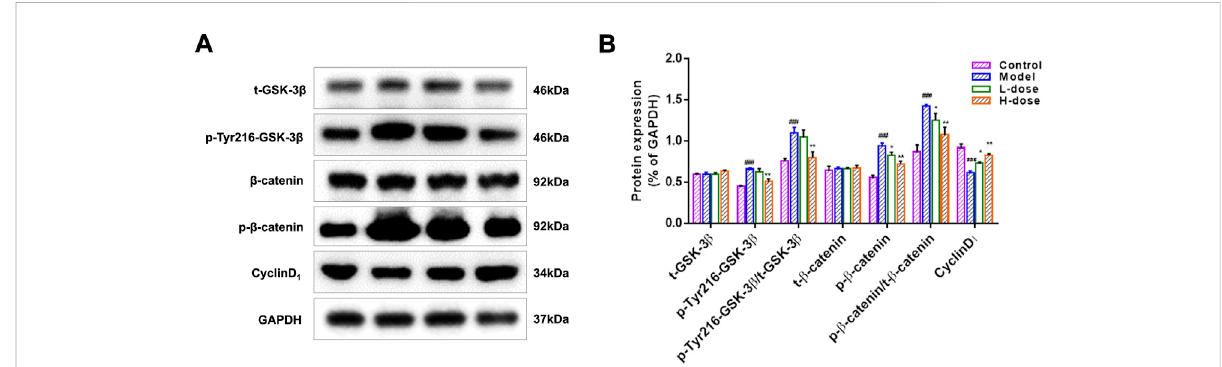
FIGURE 7 BLWE activated the expression of Wnt/ β -catenin signaling pathway-associated proteins in APP/PS1 mice. Protein expression of t-GSK-3 β , p-Tyr216-GSK-3 β , t- β -catenin, and p- β -catenin in the mice brain measured by WB, GAPDH served as control (A) . ImageJ software to quantify protein expression and normalized with GAPDH internal control (B) . ### p < 0.001 vs. the control group; * p < 0.05, ** p < 0.01 vs. the model group. Values are expressed as the mean ± SD ( n = 6 per